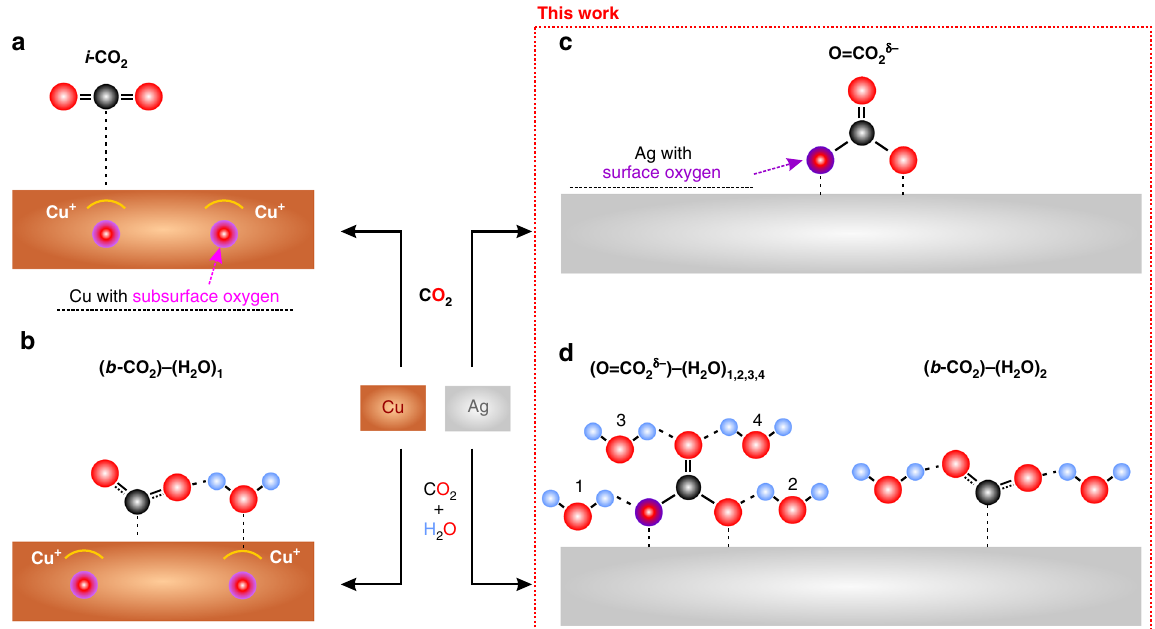
Fig. 1 Overview of surface adsorptions and reactions of CO 2 on Cu and Ag surfaces under various conditions. a , b We earlier reported CO 2 adsorption on Cu (111) at 298 K both alone and in the presence of H 2 O. These studies concluded that subsurface oxygen leads to a surface Cu + atom that stabilizes l- CO 2 suf fi ciently strongly to be stable at 298 K and 0.7 Torr ( a ). In the presence of subsurface O, we found that H 2 O adsorbs preferentially to the Cu + site while interacting suf fi ciently strongly with CO 2 to stabilize the b- CO 2 , (through a hydrogen bond ( b )) suf fi ciently to be stable at 298 K and 0.7 Torr total pressure. c , d Based on our new studies of adsorbed CO 2 on the Ag surface alone and in the presence of H 2 O at 298 K. We fi nd that l- CO 2 is not stable on Ag surface even at CO 2 pressure of 0.3 Torr at 298 K. However, CO 2 reacts strongly with surface oxygen to form a carbonic acid like structure ( c ). This O = CO 2 δ − species can stabilize one to four adsorbed H 2 O through hydrogen bonding ( d ). Furthermore, b- CO 2 can also be stabilized by a pair of surface adsorbed H 2 O each forming a hydrogen bond with an O of b- CO 2 ( d